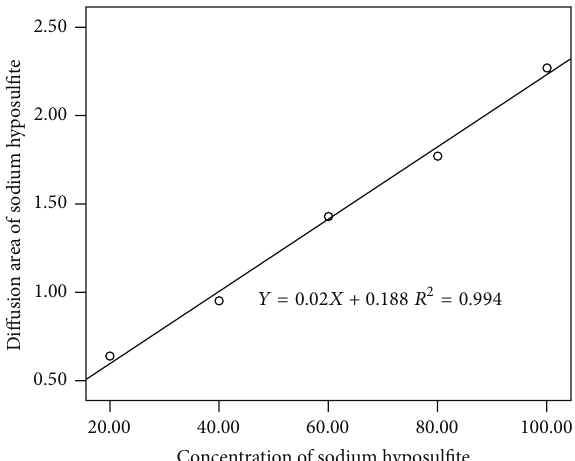
Figure 2: Linear experiment of Na 2 S 2 O 3 in 0.003 mol/L KMnO 4 .